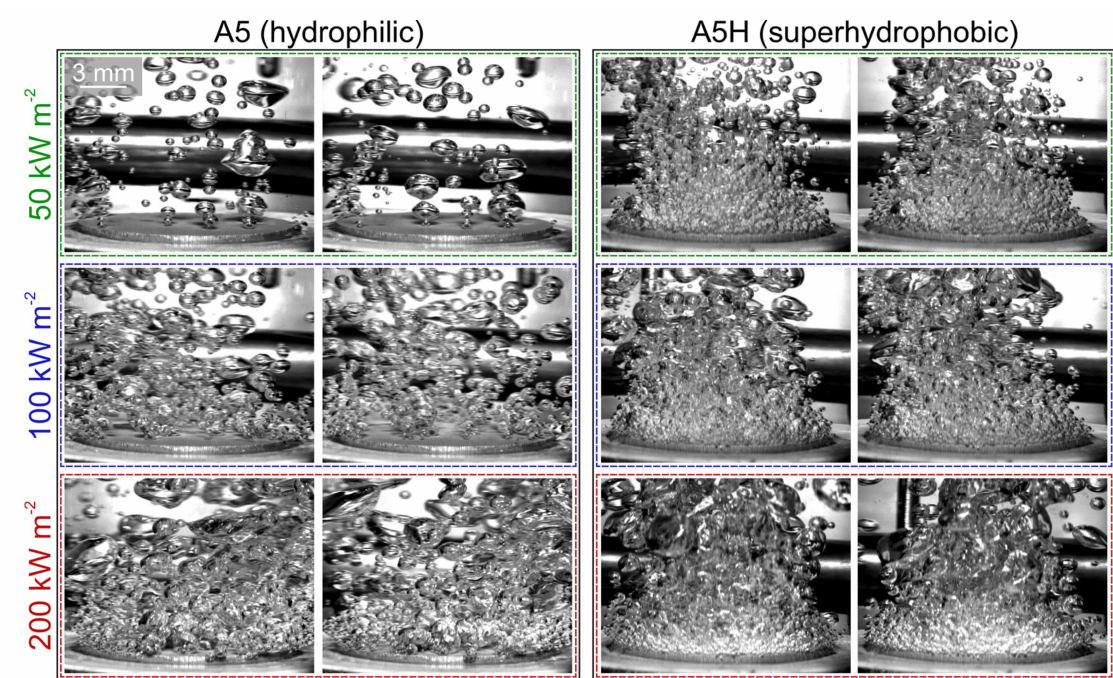
Figure 11. High speed snapshots of the boiling process on the A5 ( left column ) and A5H ( right column ) surfaces at three different heat fluxes during boiling of 1 wt.% 1-butanol mixture.